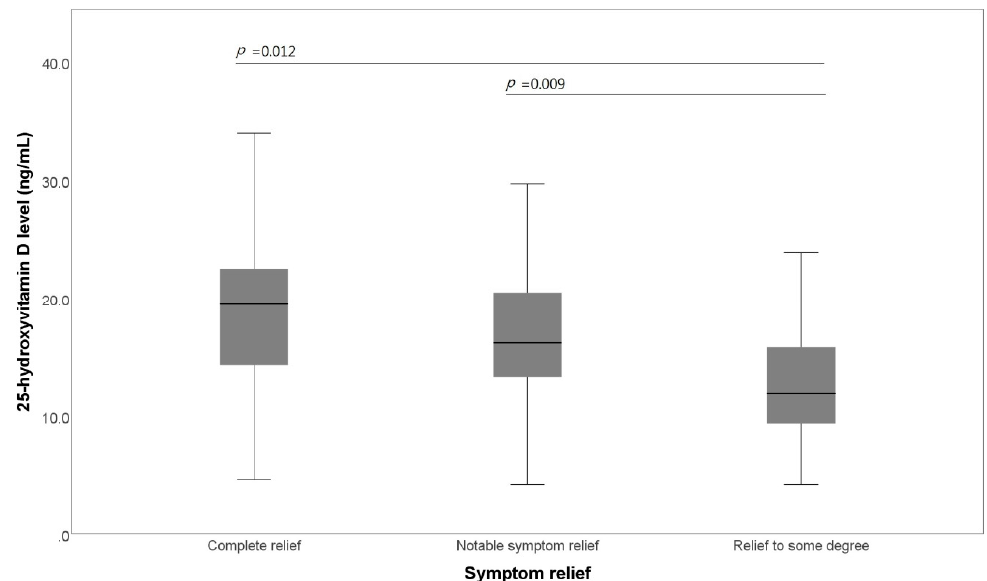
Figure 2. Box plot of the comparison of the 25-hydroxyvitamin D level and symptom relief. Patients with irritable bowel syndrome are stratified by the degree of symptom relief.